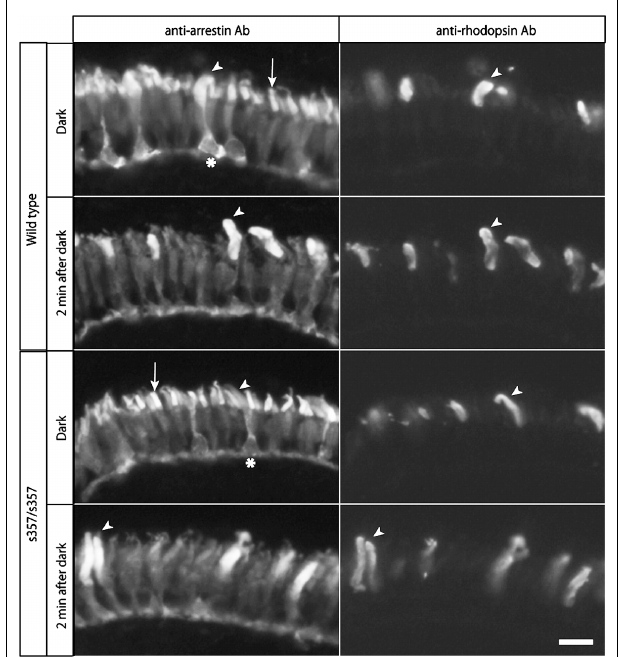
FIGURE 6 | Normal arrestin translocation in the retina. Larval retinae were subjected to double-immunostaining with anti-arrestin monoclonal antibody (left panels) and anti-rhodopsin antibody (right panels). Arrestins in both cone photoreceptors (arrows) and rod photoreceptors (arrow heads) were recognized by this antibody. In rod photoreceptor cells, arrestins were distributed across the entire cell (asterisks indicate rod cell bodies), and accumulated in the outer segments in light (2 min after 45 min dark treatment). In cone photoreceptors, arrestins were present predominantly in the outer segments in dark, and were more broadly distributed in light. Note that there were no significant differences in the light-dependent arrestin localization between the wild type and mutant retina. Scale bar: 10 μ